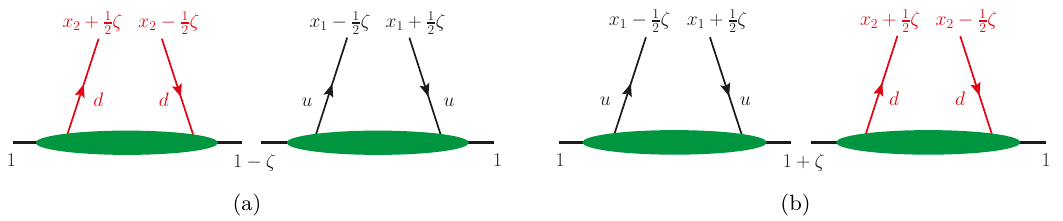
Figure 3 . (a): pictorial representation of the r.h.s. of the factorisation hypothesis (2.38). This is obtained by inserting a full set of intermediate states between the operators in the matrix element h h | O u O d | h i and then retaining only the ground state. (b): the representation obtained when in- serting the full set of states after reordering the operators to h h | O d O u | h i . All momentum fractions refer to the hadron h in the matrix element. We use form (a) for ζ ≥ 0 and form (b) for ζ < 0